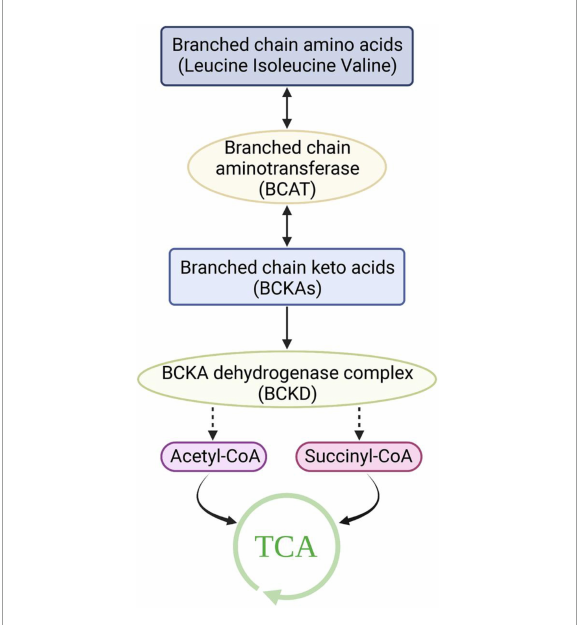
FIGURE1 Catabolism of branched-chain amino acids. TCA, Tricarboxylic acid